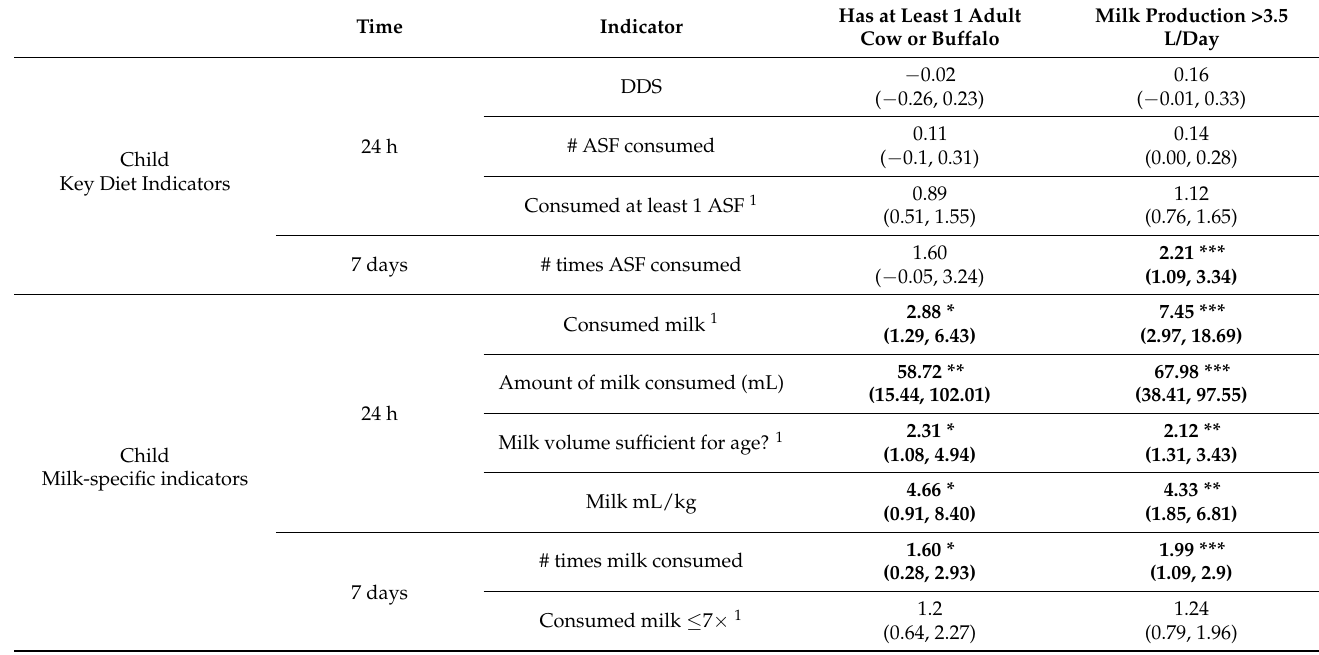
Table 4. Relationship of child and family diet indicators to dairy animal ownership and household milk production. Both dairy animal ownership and household milk production >3.5 L/d were associated with child and family diet indicators in mixed effect regressions (linear and logistic) adjusted for survey round, child (age and gender) and household (maternal education, wealth, income per capita, number of children <15 years of age). Has at Least 1 Adult Milk Production >3.5 Time Indicator Cow or Buffalo